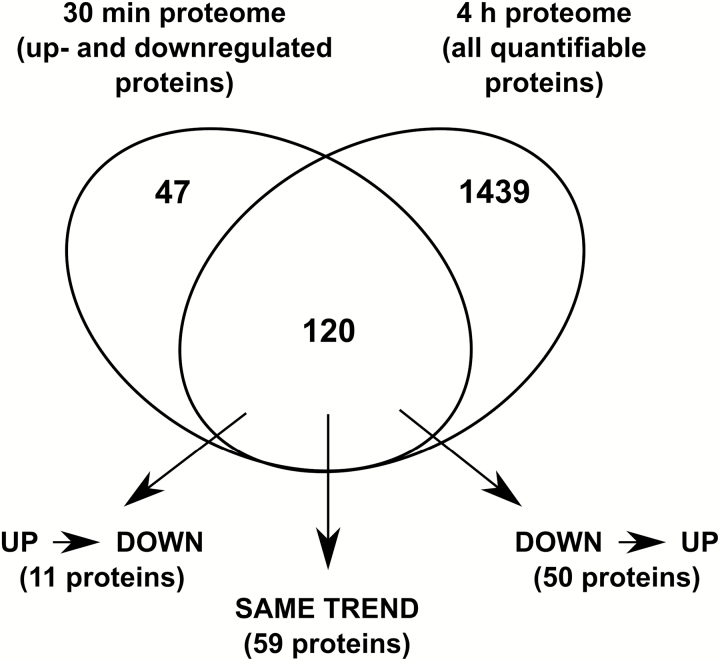
Venn diagram showing the overlap between the significant up- and down-regulated proteins from the 30 min proteome data set and all quantifiable proteins from the 4 h proteome data set. In the overlap, three subsets of proteins are identified based on the changes in their abundances from 30 min to 4 h of mannitol stress; ‘SAME TREND’ proteins are up- or down-regulated at both 30 min and 4 h, ‘UP→DOWN’ indicate proteins that are up-regulated after 30 min but down-regulated at 4 h, and ‘DOWN→UP’ indicates the opposite.